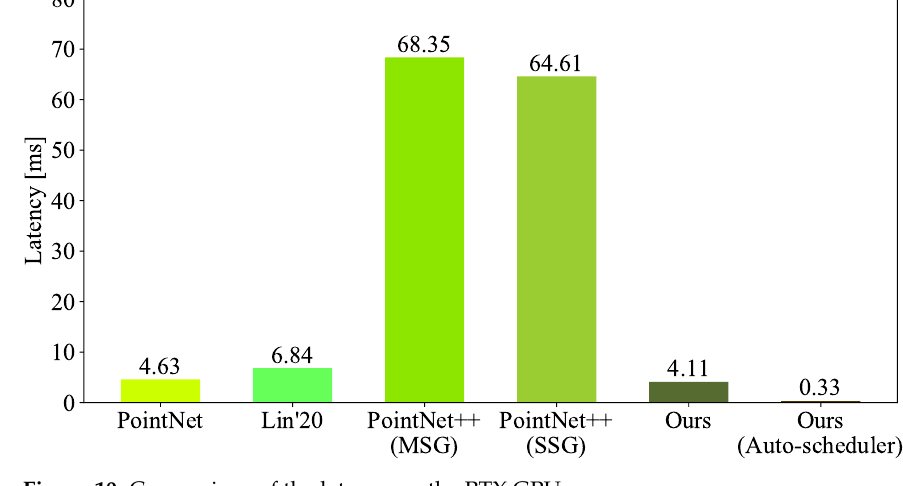
Figure 10. Comparison of the latency on the RTX GPU.